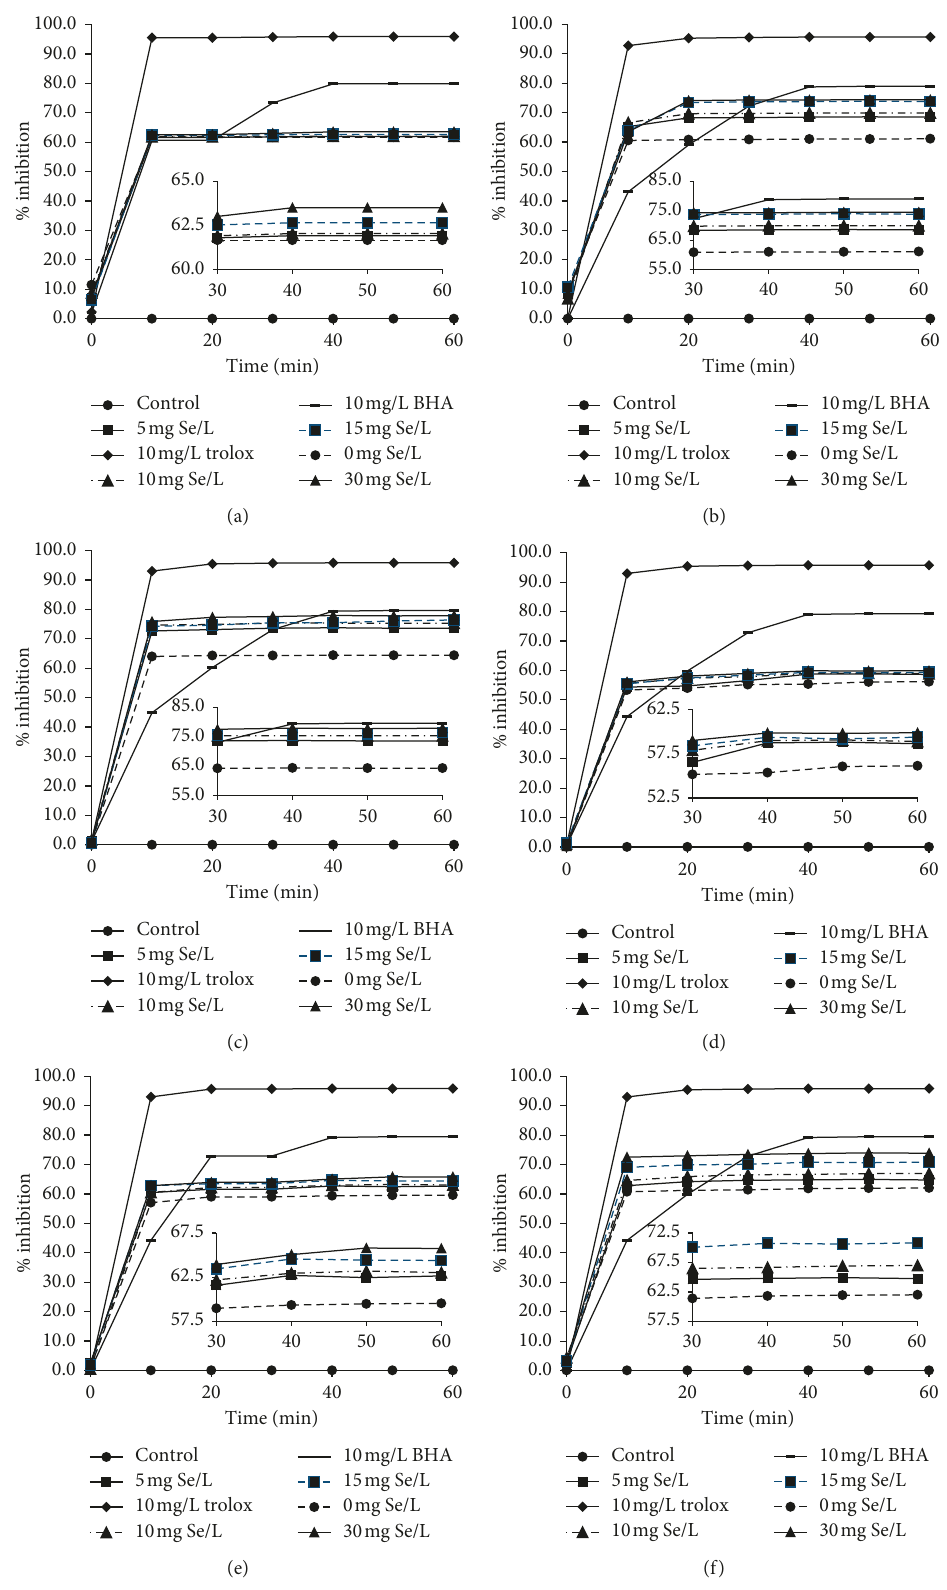
Figure 1: Kinetic behaviors of radical antioxidant activity of Se-enriched kale seedlings. The Se-enriched kale seedling ethanolic extracts (a–c) and aqueous extracts (d–f) with 5 tested Se concentrations and the two reference antioxidants trolox and butylated hydroxyanisol (BHA) in 3 cultivation periods of 5days (a, d), 10days (b, e), and 15 days (c, f). The standard represents the blank, the pure ethanol solution and the distilled